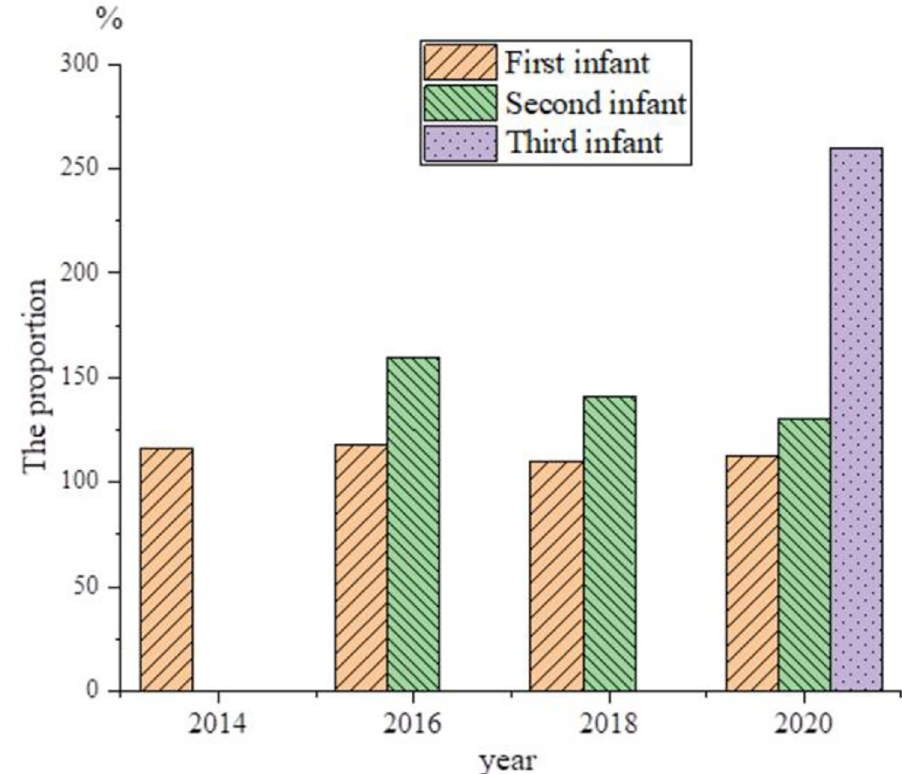
Fig 4. Sex ratio of birth